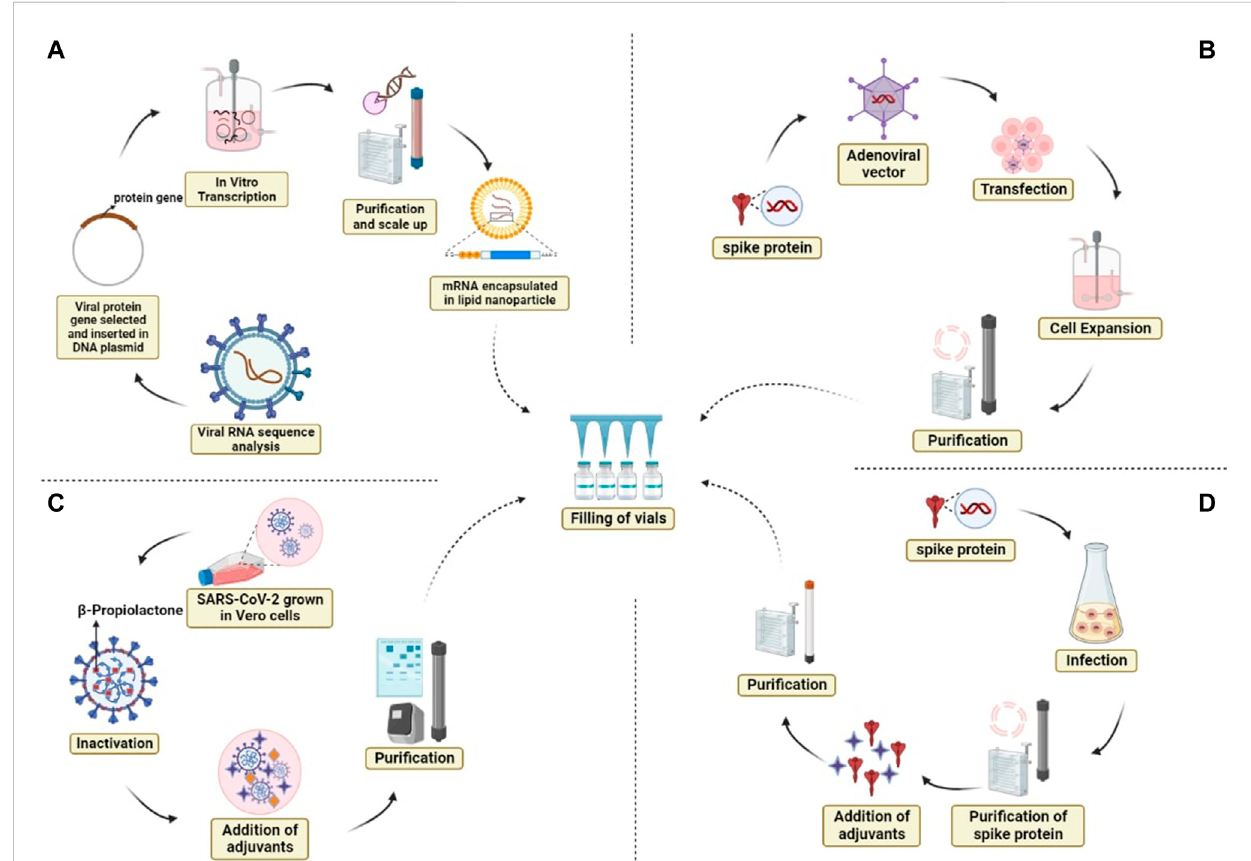
Different platforms for vaccine production and their modes of action. (A) mRNA vaccine, (B) adenoviral vector vaccine, (C) whole inactivated virus, and (D) protein subunit